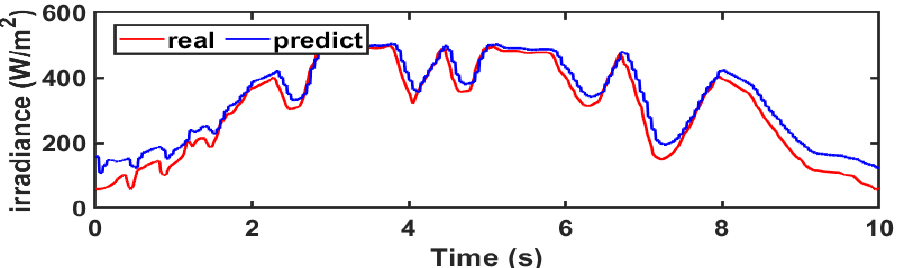
Figure 10. Comparison of real and predicted data to check deep learning model performance.